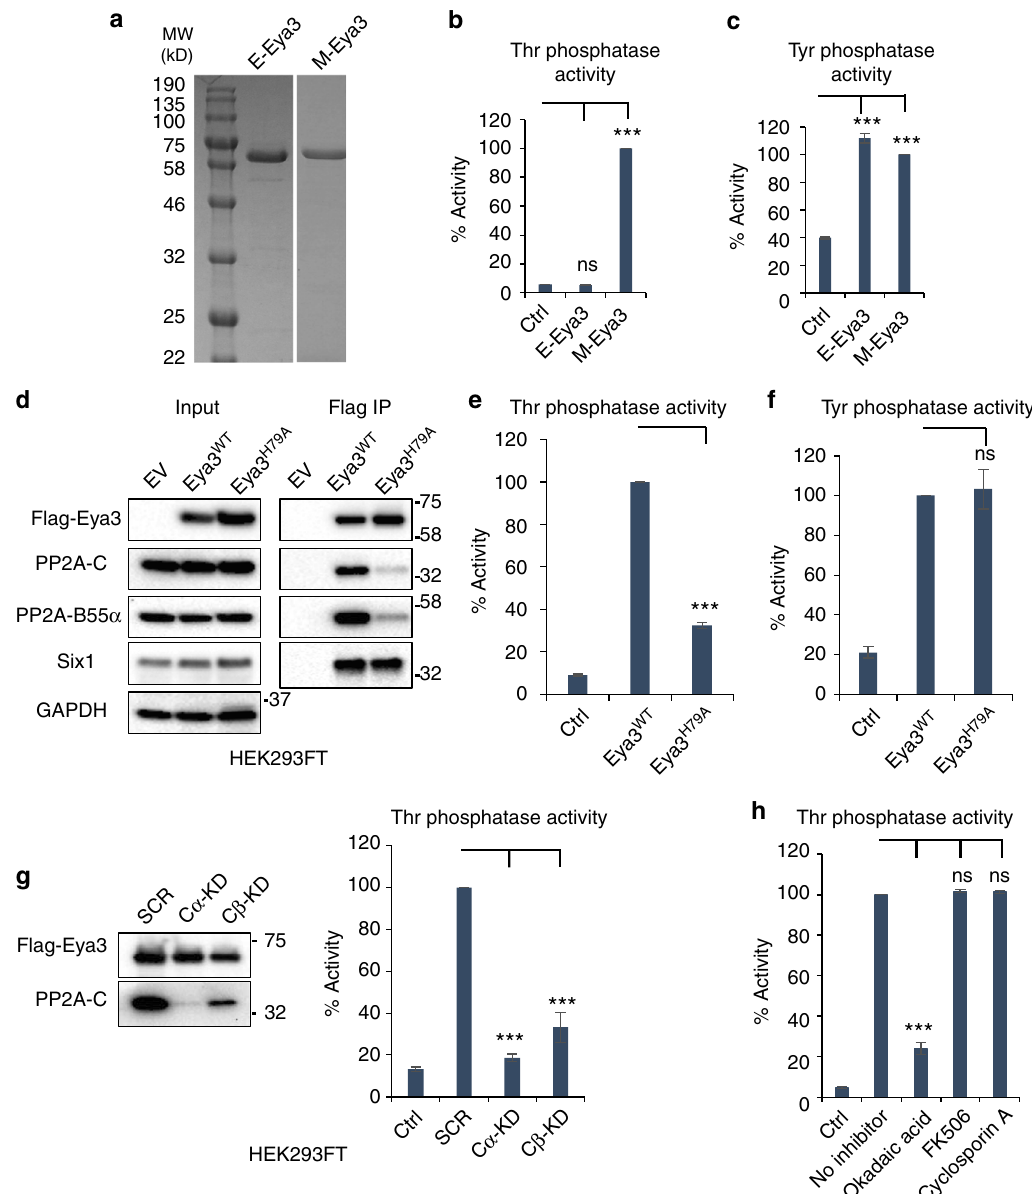
Fig. 1 The Thr phosphatase activity of Eya3 arises from its association with PP2A. a SDS PAGE gel shows mEya3 puri fi ed from E. coli (E-Eya3) and mammalian HEK293FT cells (M-Eya3). b Thr and c Tyr phosphatase activities of E-Eya3 and M-Eya3 were analyzed in malachite-green-based phosphatase assays using phosphor-Thr (KRpTIRR) or phosphor-Tyr (pH2AX, KATQASQEpY) peptide as substrates. All phosphatase activities were normalized to the amount of protein used in the assay. The phosphatase activity of M-Eya3 was set to 100%. All control reactions (Ctrl) in Fig. 1 refer to samples in which no protein was added. d Immunoprecipitation (IP) using a Flag antibody was conducted on lysates of HEK293FT cells transfected with empty vector (EV), Flag-Eya3 (Eya3 WT ) or Flag-H79A mutant Eya3 (Eya3 H79A ). Western blot analysis of IPs shows that the H79A mutation diminishes the interaction of Eya3 with PP2A, but does not affect the interaction of Eya3 with Six1. Molecular weight markers in kilodalton are labeled on the side of western blots. e Thr and f Tyr phosphatase activities of Eya3 WT and Eya3 H79A were evaluated using Eya3 immunoprecipitated from HEK293FT cells. Eya3 WT phosphatase activity was set to 100%. g Thr phosphatase activity assay was conducted using Eya3 immunoprecipitated from scramble control (SCR), PP2A-C α , or PP2A-C β KD HEK293FT cells. Left: IP using a Flag antibody followed by western blot analysis shows that similar levels of Eya3 protein were obtained from HEK293FT cells transduced with scramble shRNA, PP2A-C α shRNA, or PP2A-C β shRNA, whereas Eya3 associates with less PP2A when PP2A-C α or PP2A-C β is KD. Right: Thr phosphatase assay using Eya3 proteins shown in left panel. Phosphatase activity for SCR group was set to 100%. h Thr phosphatase activity assay was performed using M-Eya3 in the presence of DMSO (no inhibitor), PP2A inhibitor okadaic acid (2.5 nM), PP2B inhibitor FK506 (5 μ M), or calcineurin inhibitor cyclsoporin A (5 μ M). The no inhibitor group was set to 100% phosphatase activity. Data shown are mean ± SD from three independent experiments. In the phosphatase activity assay, the p -value is calculated using one-way ANOVA followed by Tukey test, ** p < 0.01, and *** p <